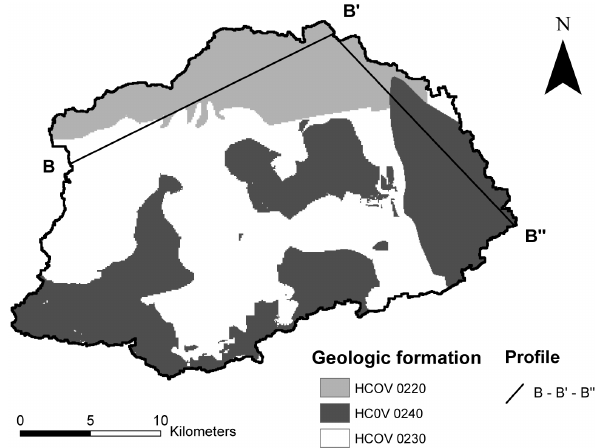
Fig. 2. Occurrence of the Campine clay-sand complex (0220) and Pliocene clay layer (0240), as described in Table 1. Other layers oc- cur throughout the basin. The profile B-B’-B” is presented in Fig. 3.